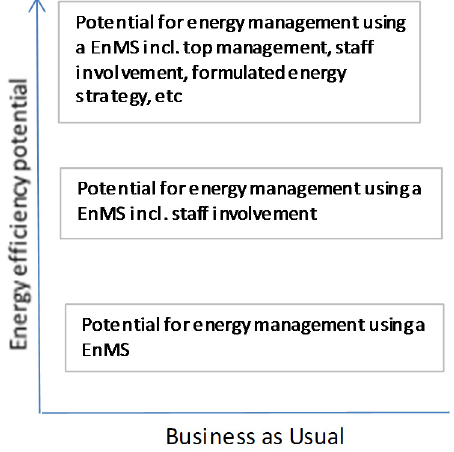
Figure 1. The energy efficiency potentials for various energy management